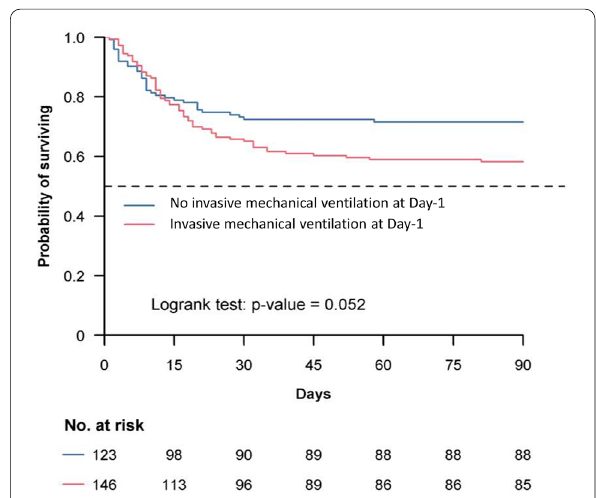
Fig. 3 Kaplan–Meier survival estimates during the 90 days following ICU admission in propensity score-matched